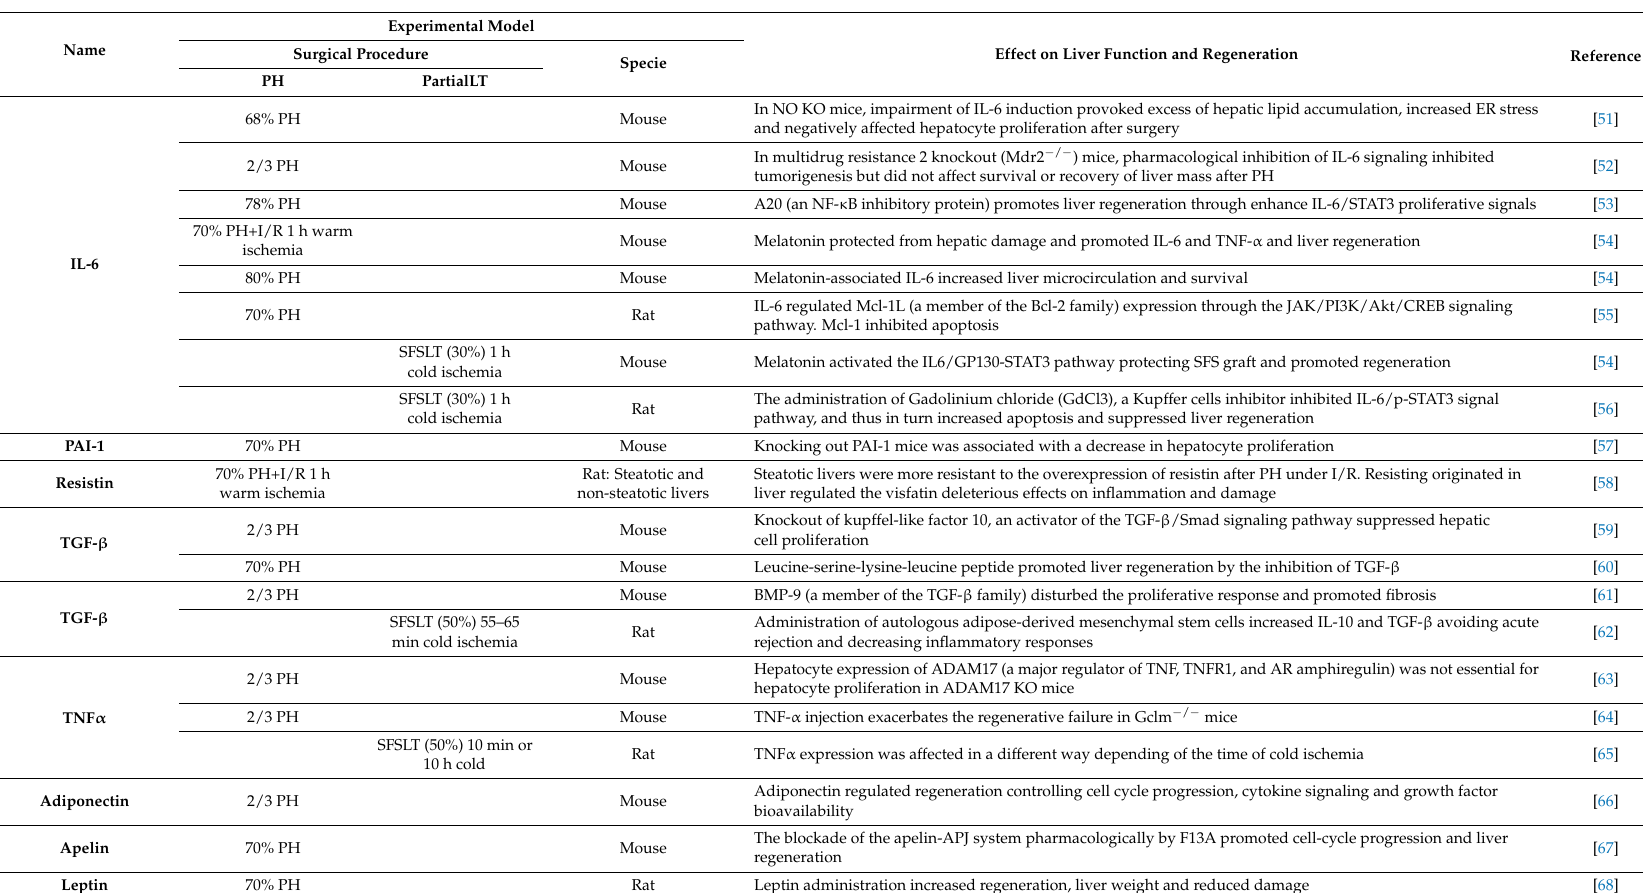
Table 2. Summarizes reported studies performed in partial hepatectomy (PH) models evaluating roles and mechanisms of adipokines in liver regeneration and damage in the last five